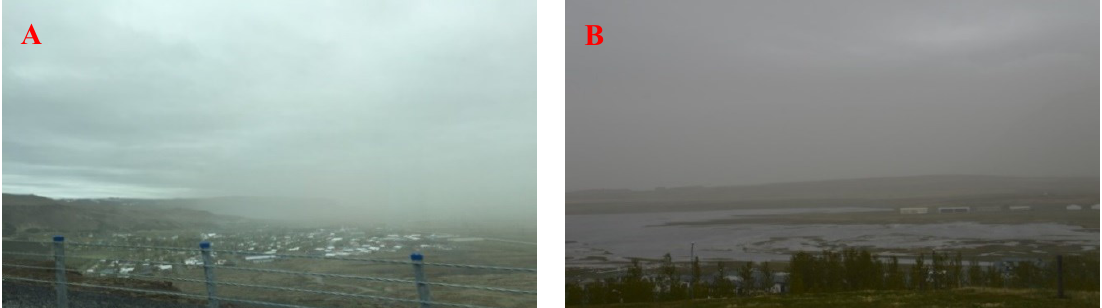
Figure 6. ( A ) The dust front of Storm 1 approaching to the town Hveragerði, population of 2300, which is near the town Selfoss, the eighth largest community in Iceland, with about 6500 inhabitants. The highest PM concentrations were measured in this area. The margin of the dust plume is very clear. Reduced visibility due to dust in Mosfellsbær (near Reykjavik), overlooking river Leirá, is shown on the right picture ( B ). Here the concentrations exceeded 400 µg·m −3 for PM 10 and 100 µg·m −3 for PM 1 .